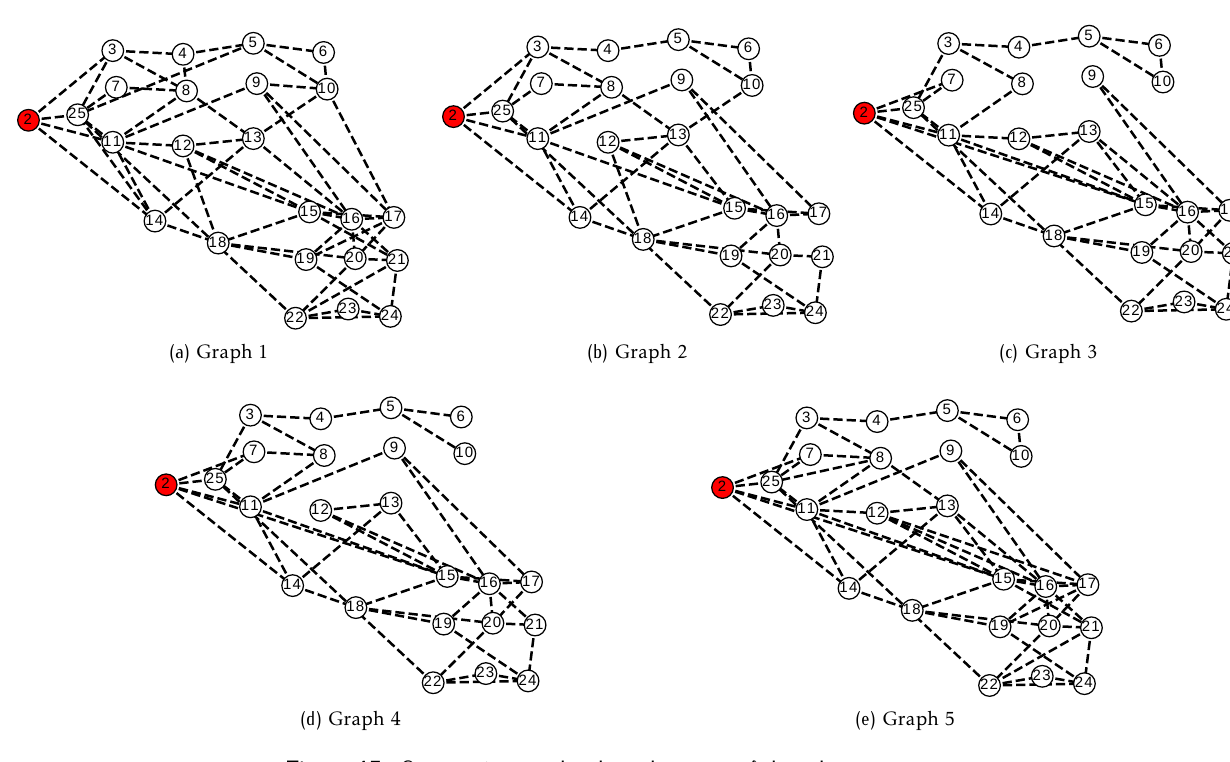
Figure 15. Consecutive graphs show that most of the edges are common